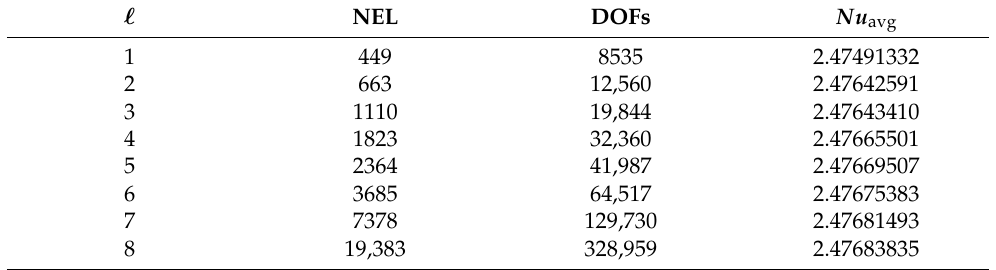
Table 2. The test for grid convergence.